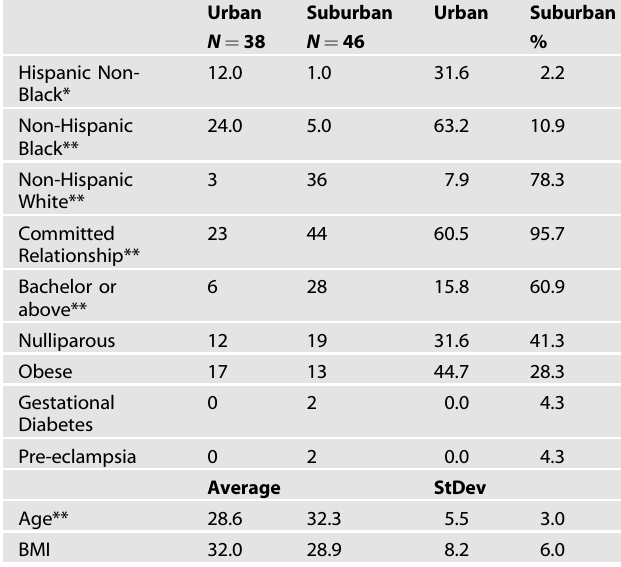
Table 1. Demographic characteristics of the urban and suburban